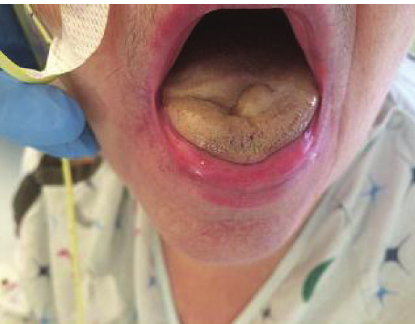
Figure 1: Discoloration and swelling of the anterior half of the tongue upon initial evaluation.